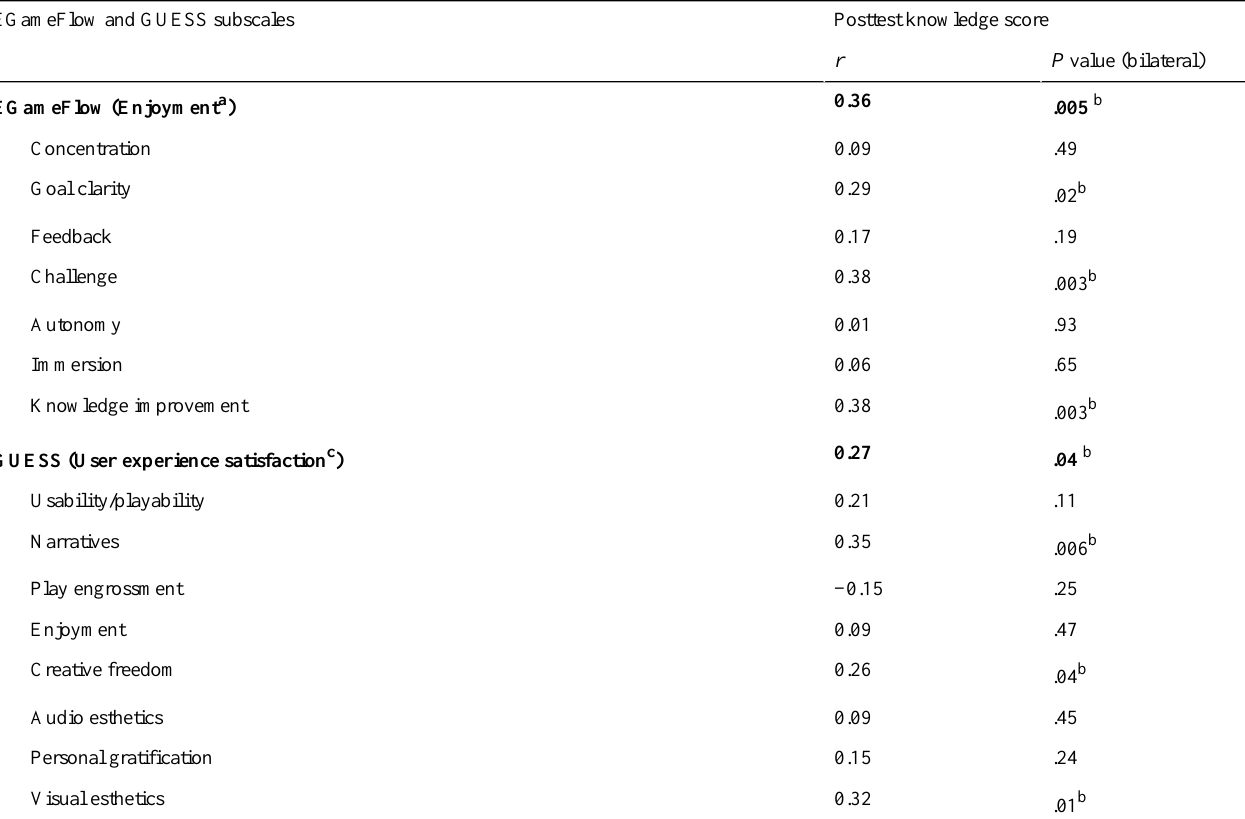
Table 1. Bilateral correlations of children’s posttest knowledge with EGameFlow and Guess scales and subscales.